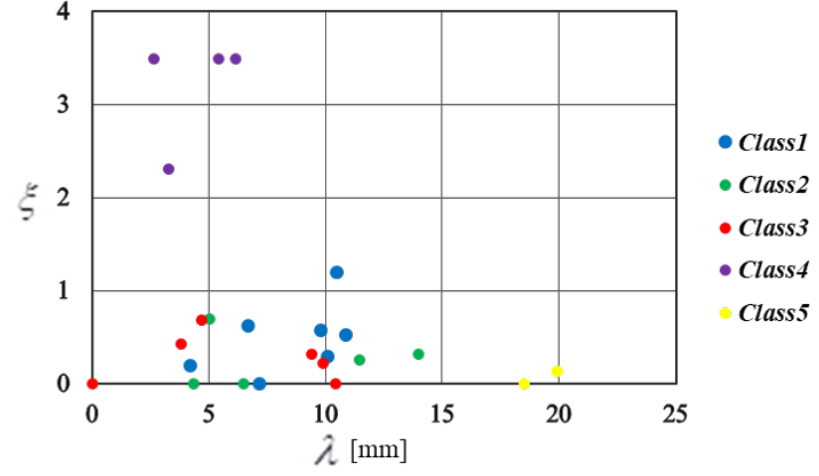
Figure 10. Clustering results of measuring points indicated by temporal